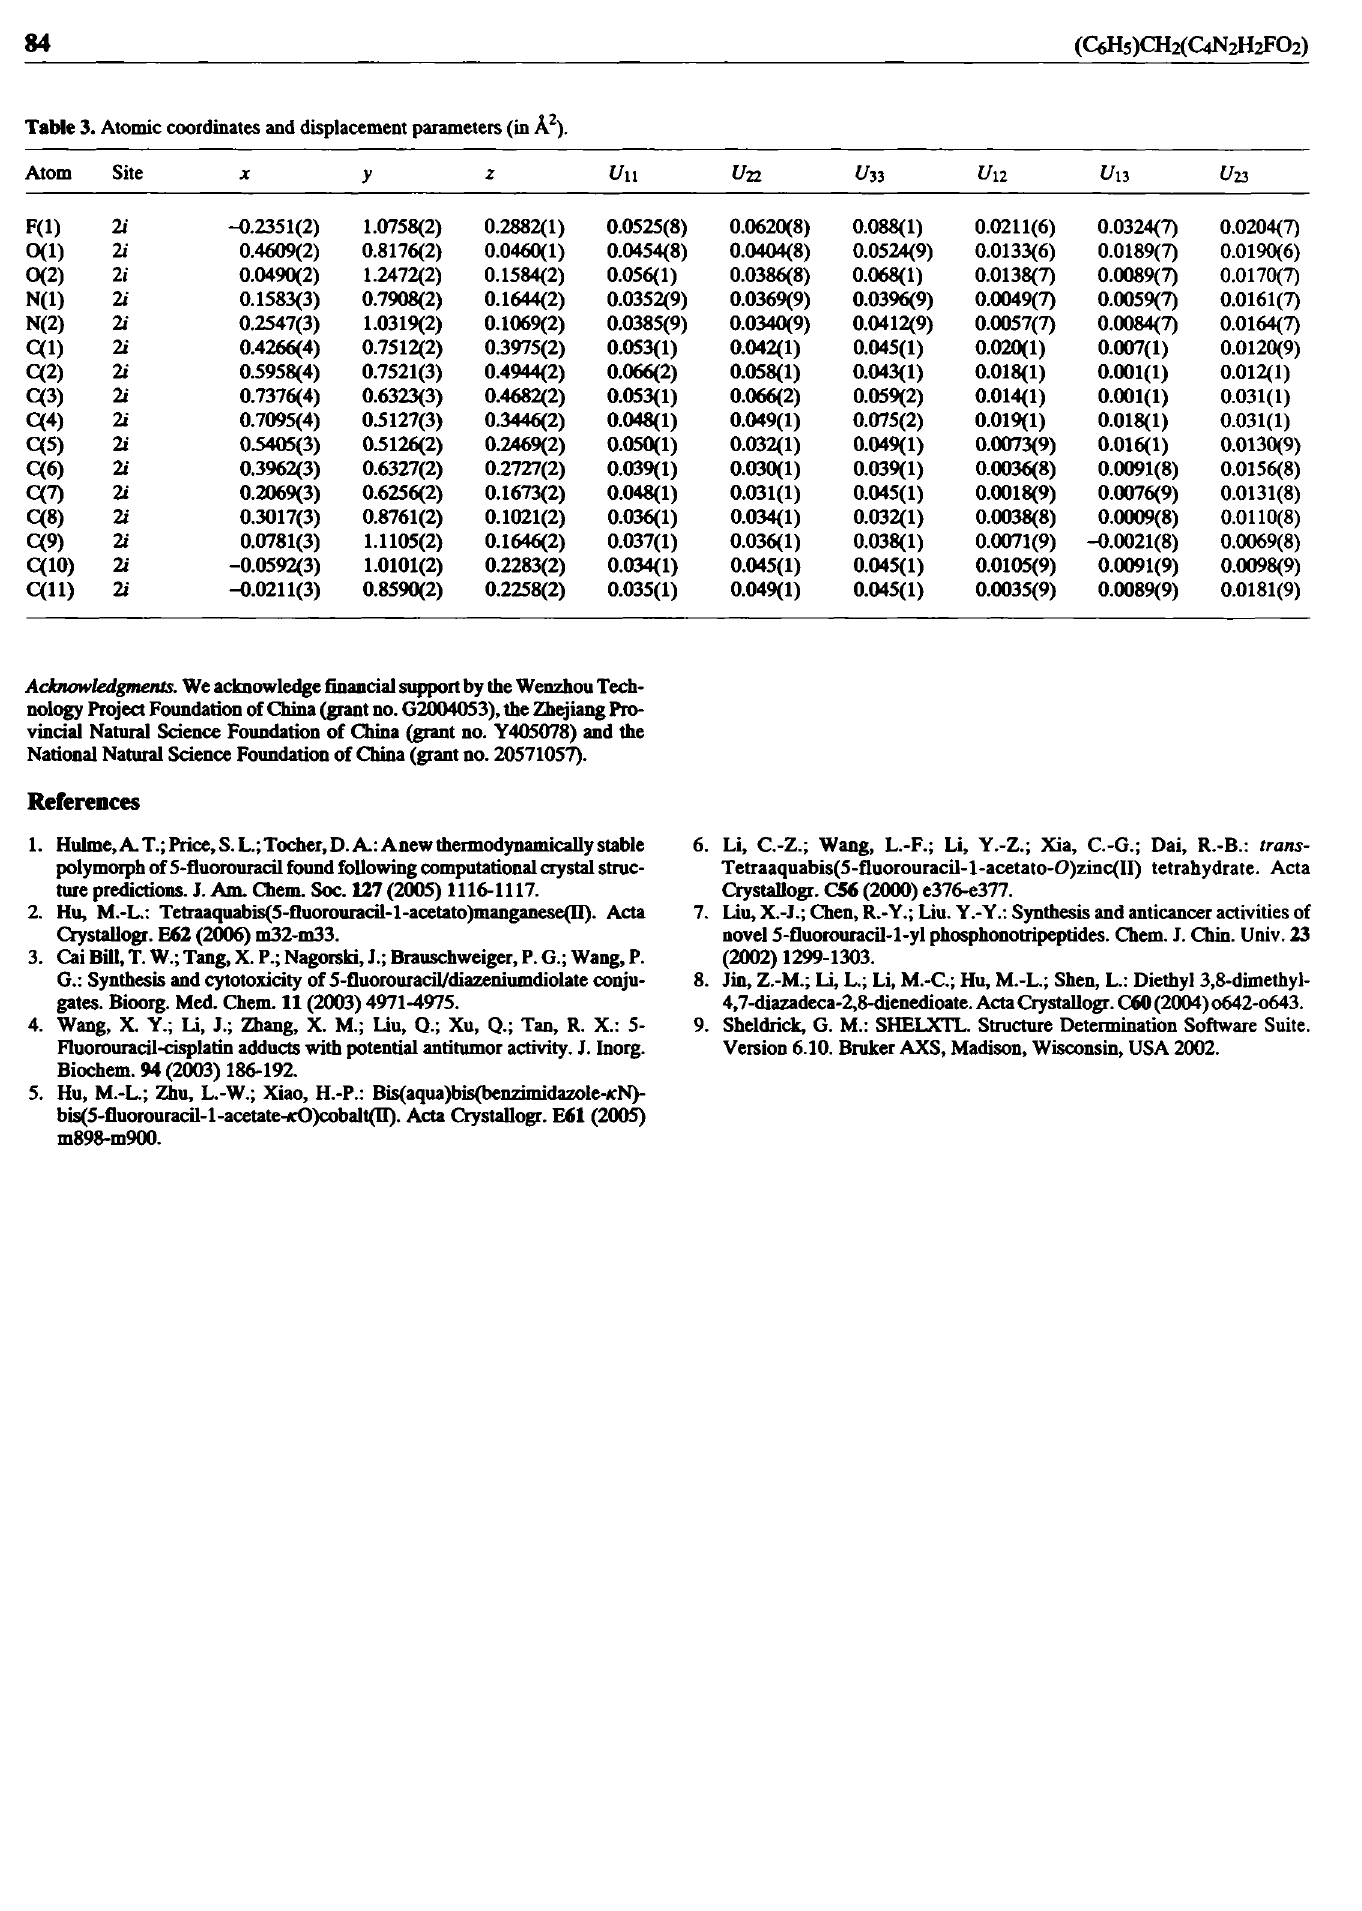
Table 3. Atomic coordinates and displacement parameters (in Ä 2